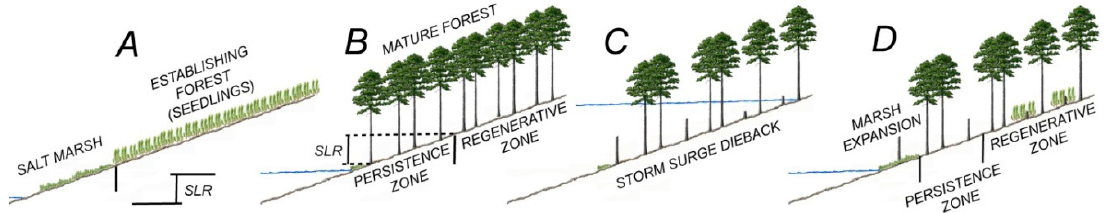
Figure 1. Ecological ratchet model of marsh transgression in a coastal forest [24]. After forest establishment ( A ) sea level rises, creating a persistence zone where mature trees survive under stress but cannot regenerate ( B ). A storm hits the forest triggering a dieback ( C ). Only in the regenerative zone seedlings can grow back and the forest recovers, while the marsh expands in the persistence zone ( D ). Note that the upper boundary of the persistence zone moves with sea level (press disturbance), while the lower boundary moves during storms (pulse disturbance).